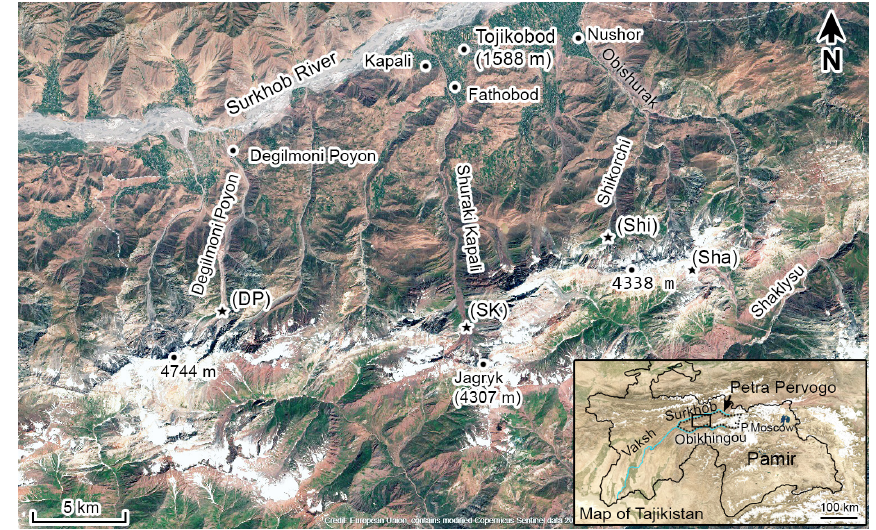
Figure 1. Western Petra Pervogo range. The (cid:63) symbols indicate catchments where large mass flows involving glacier ice occurred. Catch- ments are abbreviated by river names (DP, SK, Shi, Sha). Image contains Copernicus Sentinel-2 and MODIS data with borders, major rivers, and place names